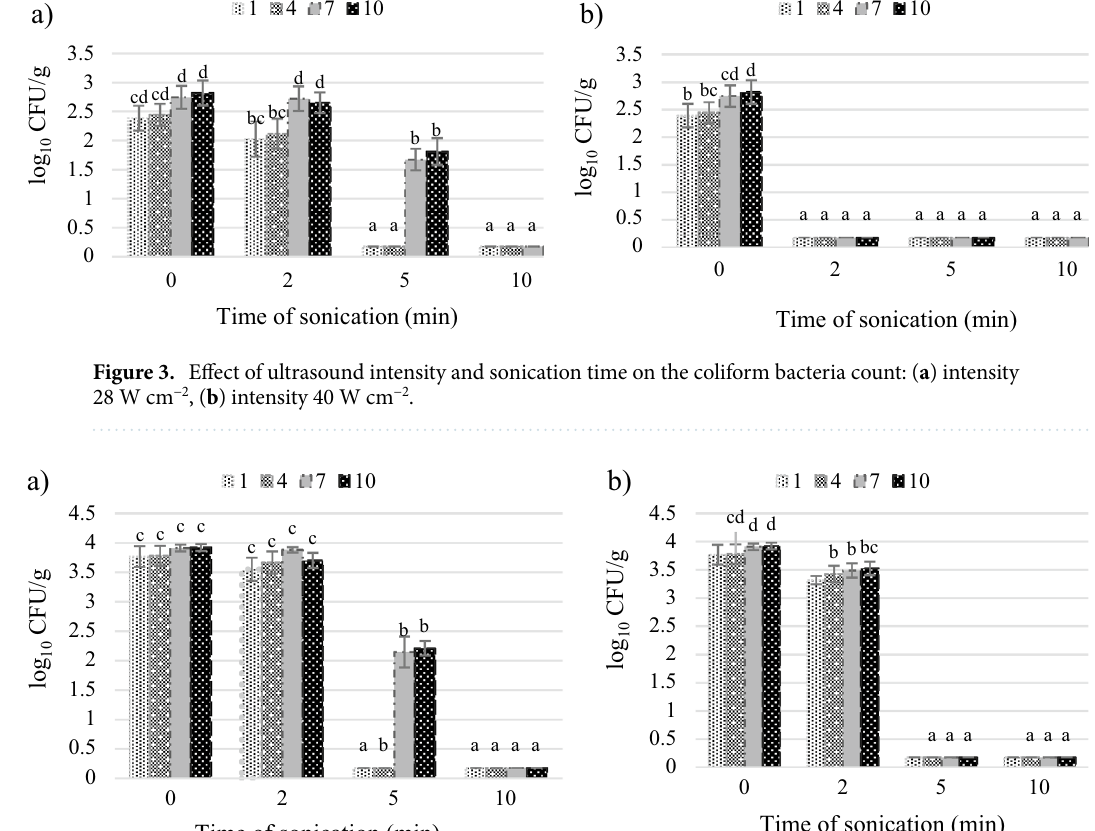
Figure 4. Effect of ultrasound intensity and sonication time on the total yeast count: ( a ) intensity 28 W cm −2 , ( b ) intensity 40 W cm −2